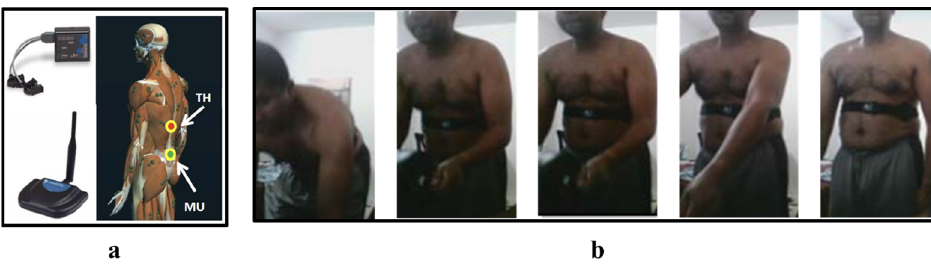
Figure 2. ( a ) Thoracic (upper-back) and Multifidus (lower-back) EMG-sensor positions. ( b ) The research team member lifting the weights.